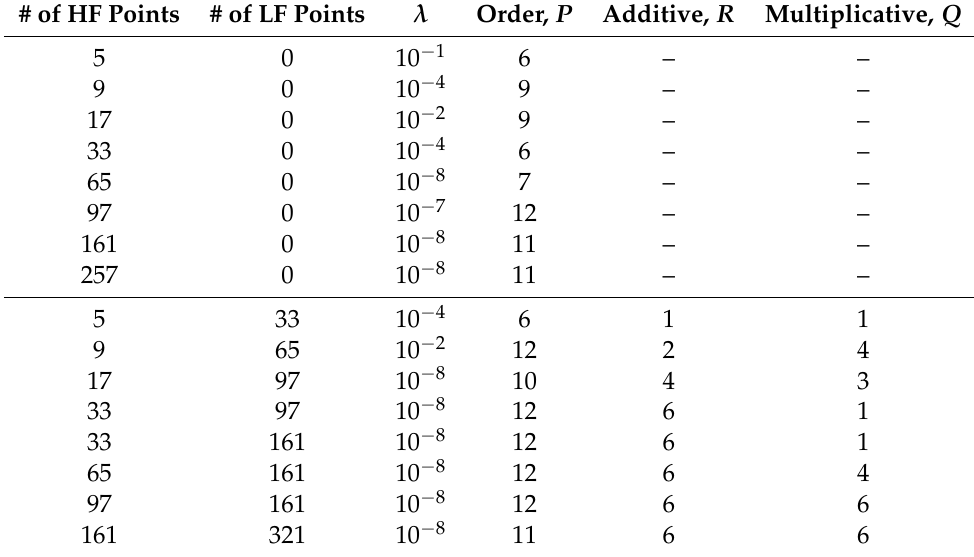
Table 6. Best order and λ values for the two-dimensional coupled spring-mass-system using MF